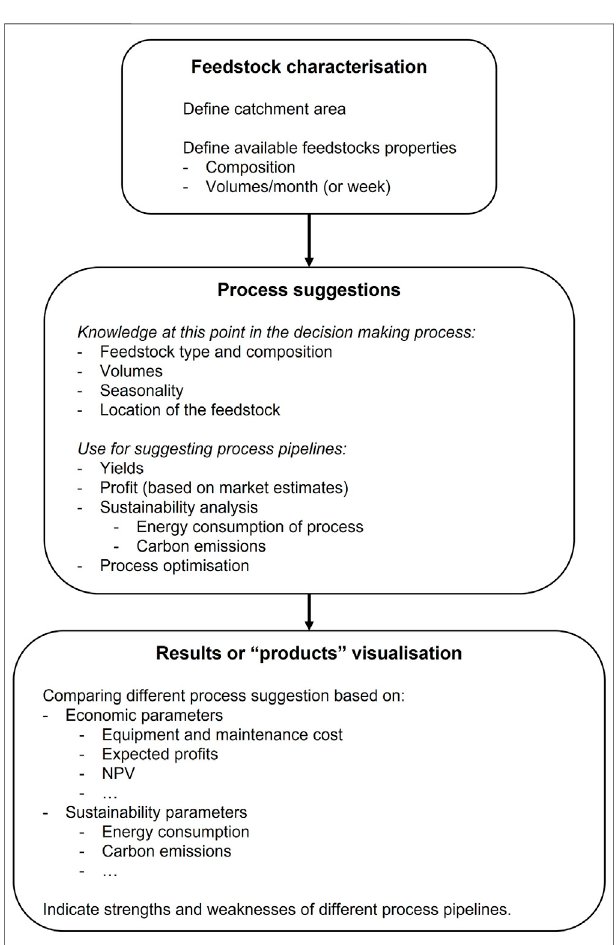
FIGURE 3 | Flowsheet representing the biore fi nery designing process and the accompanying strategic decisions, starting from the feedstock entry